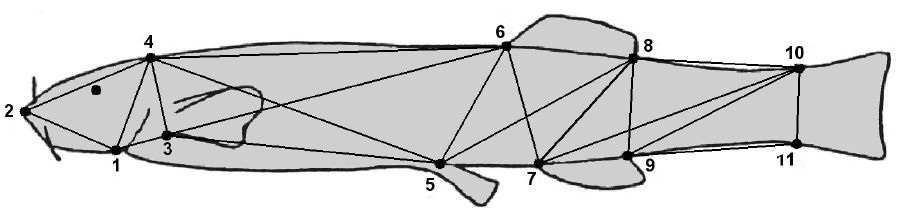
Figure 2. Position of the anatomical landmarks used to measure the size of 22 morphological characters on Trichomycterus areolatus based on a truss network. Definition of each character and its classification according to body shape dimension covered by them was as follows: a Head length, 1–2 = ventral tip of the operculum to tip of the head, 2–4 = tip of the head to posterior margin of the head b Head depth, 1–4 = ventral tip of the operculum to posterior margin of the head, 3–4 = base of the pectoral fin to posterior margin of the head c Anterior body length, 1–3 = ventral tip of the operculum to base of the pectoral fin, 3–5 = prepelvic length; 4–5 = posterior margin of the head to base of the pelvic fin; 3–6 = base of the pectoral fin to anterior base of the dorsal fin; 4–6 = predorsal length d Middle body depth, 5–6 = base of the pelvic fin to anterior base of the dorsal fin, 5–8 = base of the pelvic fin to posterior base of the dorsal fin, 6–7 = anterior base of the dorsal fin to anterior base of the anal fin, 7–8 = anterior base of the anal fin to posterior base of the dorsal fin e Middle body length, 5–7 = base of the pelvic fin to anterior base of the anal fin, 6–8 = dorsal fin base length, 7–9 = anal fin base length f Posterior body length, 7–10 = anterior base of the anal fin to dorsal posterior margin of the caudal peduncle, 9–10 = posterior base of the anal fin to dorsal posterior margin of the caudal peduncle g Peduncle depth, 8–9 = anterior caudal peduncle depth, 10–11 = posterior caudal peduncle depth h Pedun- cle length, 8–10 = dorsal caudal peduncle length, 9–11 = ventral caudal peduncle